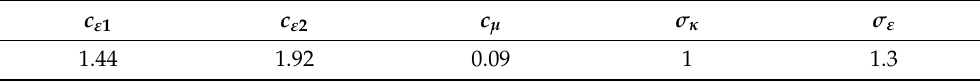
Table 2. Turbulence